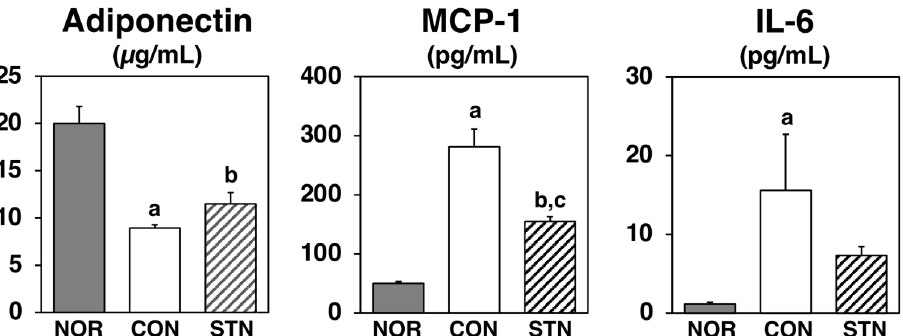
Figure 3. Adipocytokines levels in the serum of C57BL/6J and db / db mice fed experimental diets for 4 weeks. Values are expressed as the mean ± standard error ( n = 5). a Significant difference at p < 0.05 between NOR and CON; b significant differences at p < 0.05 between NOR and STN; c significant differences at p < 0.05 between CON and STN.